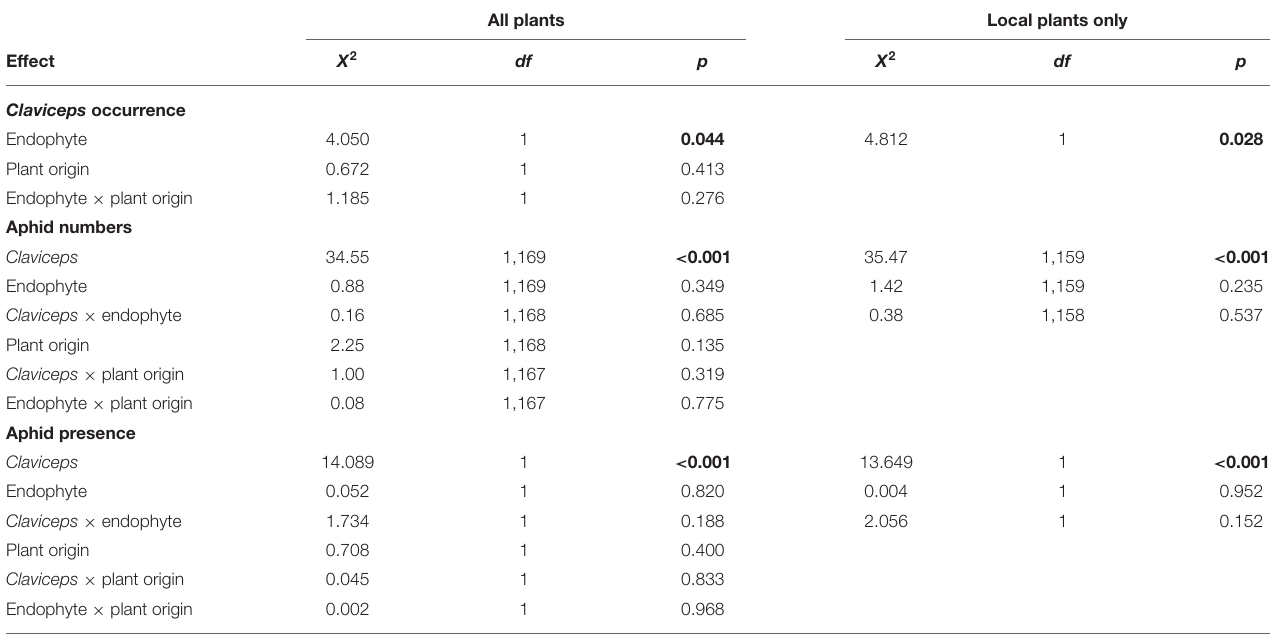
TABLE 1 | Summary of the fixed effects used in the models. All plants Local plants only